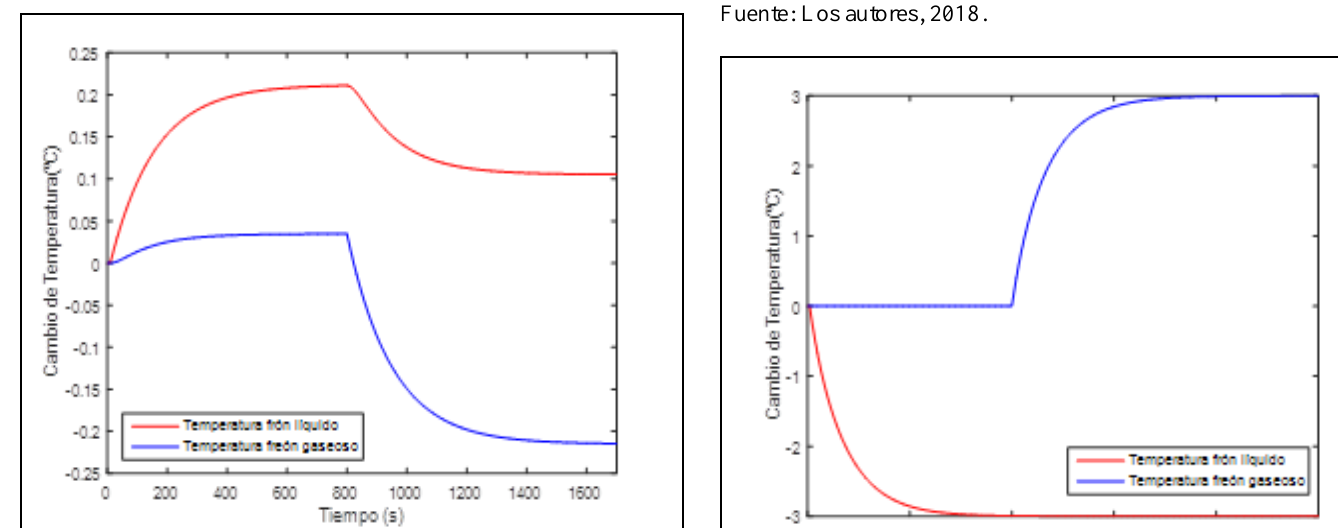
Figura 6: Respuesta del sistema multivariable a lazo abierto. Fuente: Los autores, (2018).